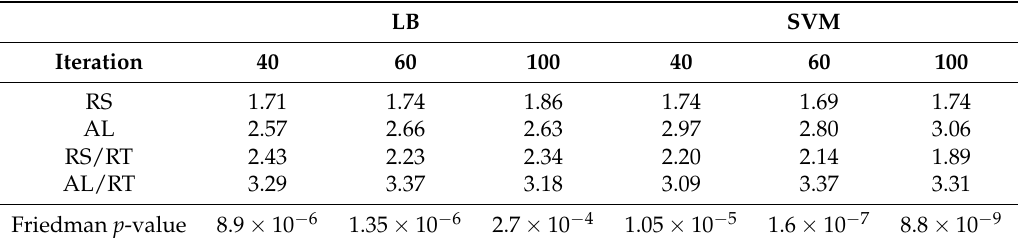
Table 1. Average rankings of the sampling strategies and Friedman P-values